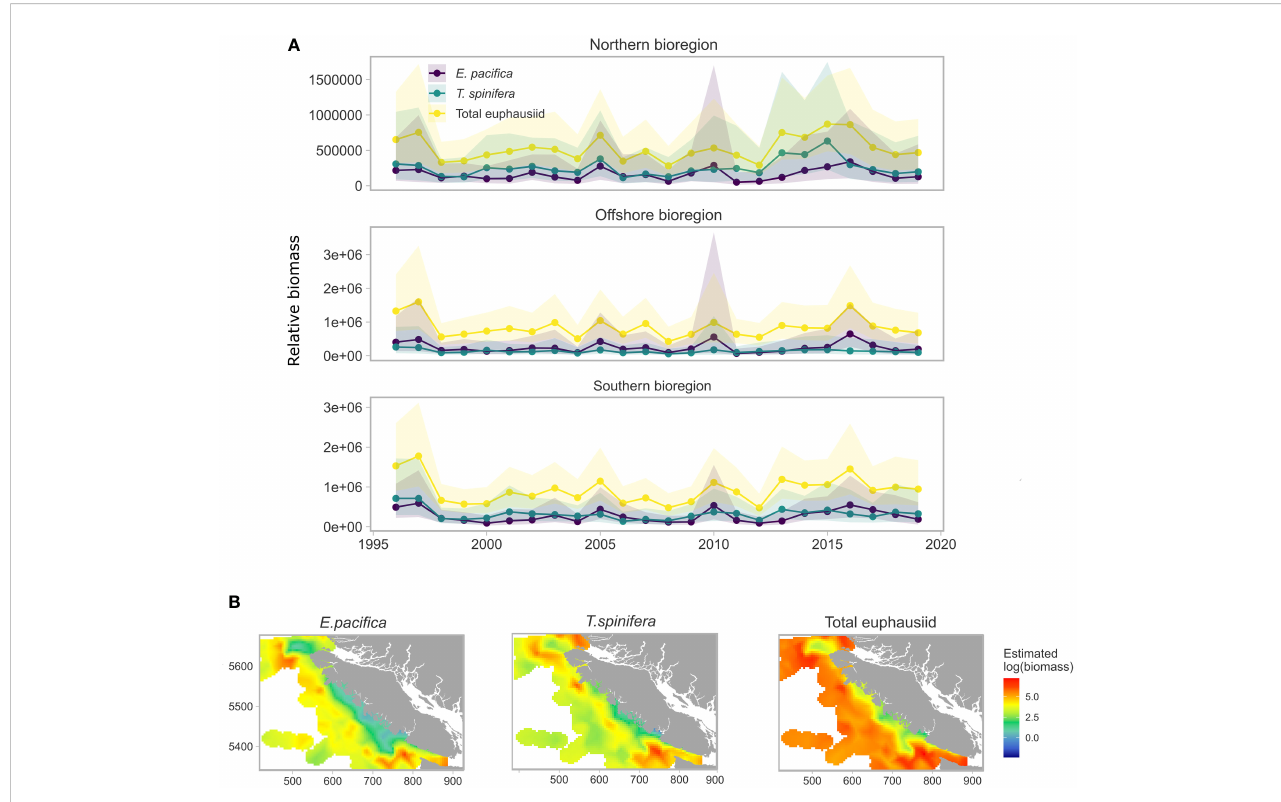
FIGURE 6 Spatial and temporal means estimated from euphausiid models and predicted on 5km 2 covariate grid. (A) Relative mean predicted biomass of E. paci fi ca , T. spinifera and total euphausiid for each bioregion for each year, (B) . Spatial distribution of mean predicted biomass for each of the three euphausiid